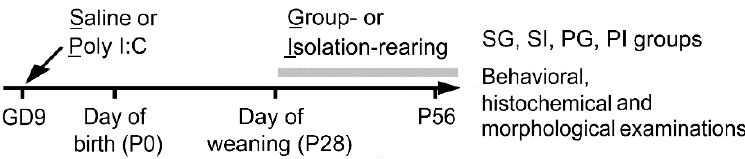
Figure 1. Experimental design. Saline or poly I:C (2 mg / kg) was intraperitoneally given to the pregnant mice at gestation day (GD) 9. On the day of weaning, postnatal day (PD) 28, male o ff spring were divided into groups or isolation-rearing groups. Four groups of animals were then examined after PD 56.